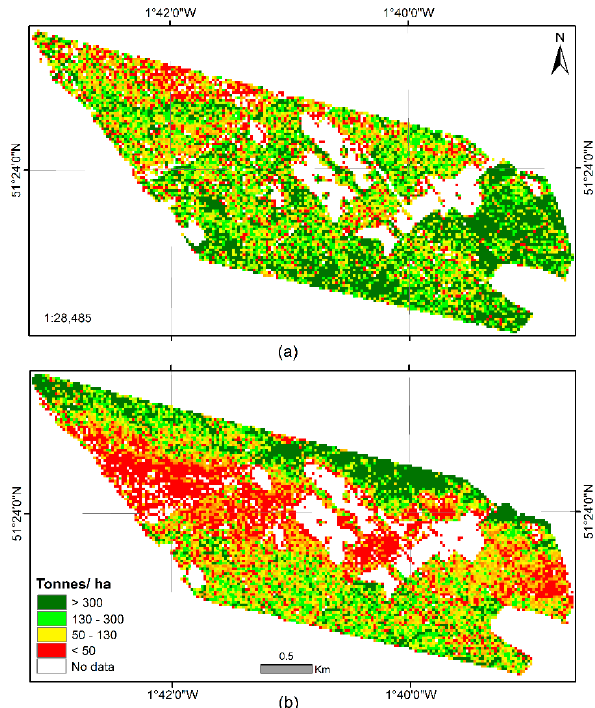
Figure 9. Predicted AGB maps using S-band HH backscatter at 25 m resolution for Savernake Forest in 2010 ( a ) and 2014 ( b ) using field biomass estimates.